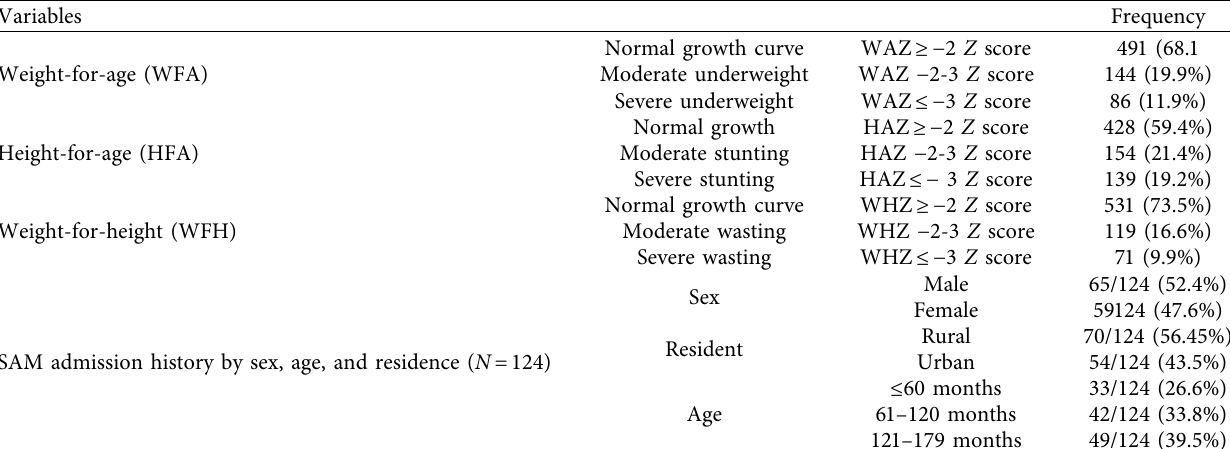
Table 3: Nutritional status of seropositive children attending ART cares in selected health facility at Benishangul Gumuz regions, 2020 ( n � 721).